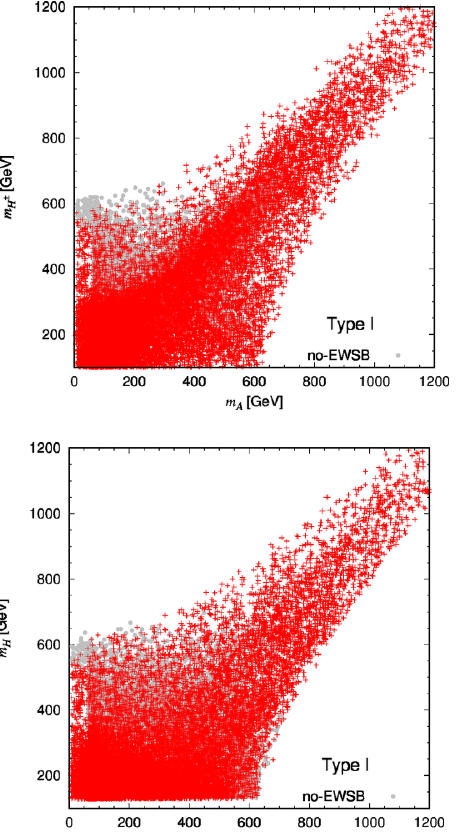
(cid:21) 580 GeV [54] H (cid:6)